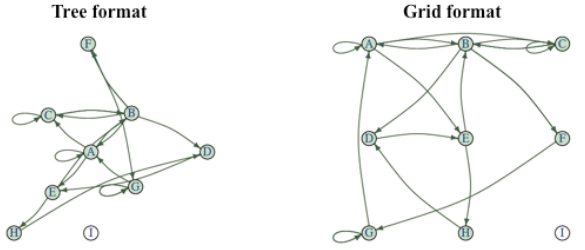
Figure A1. Network representation of the transition matrix in two formats